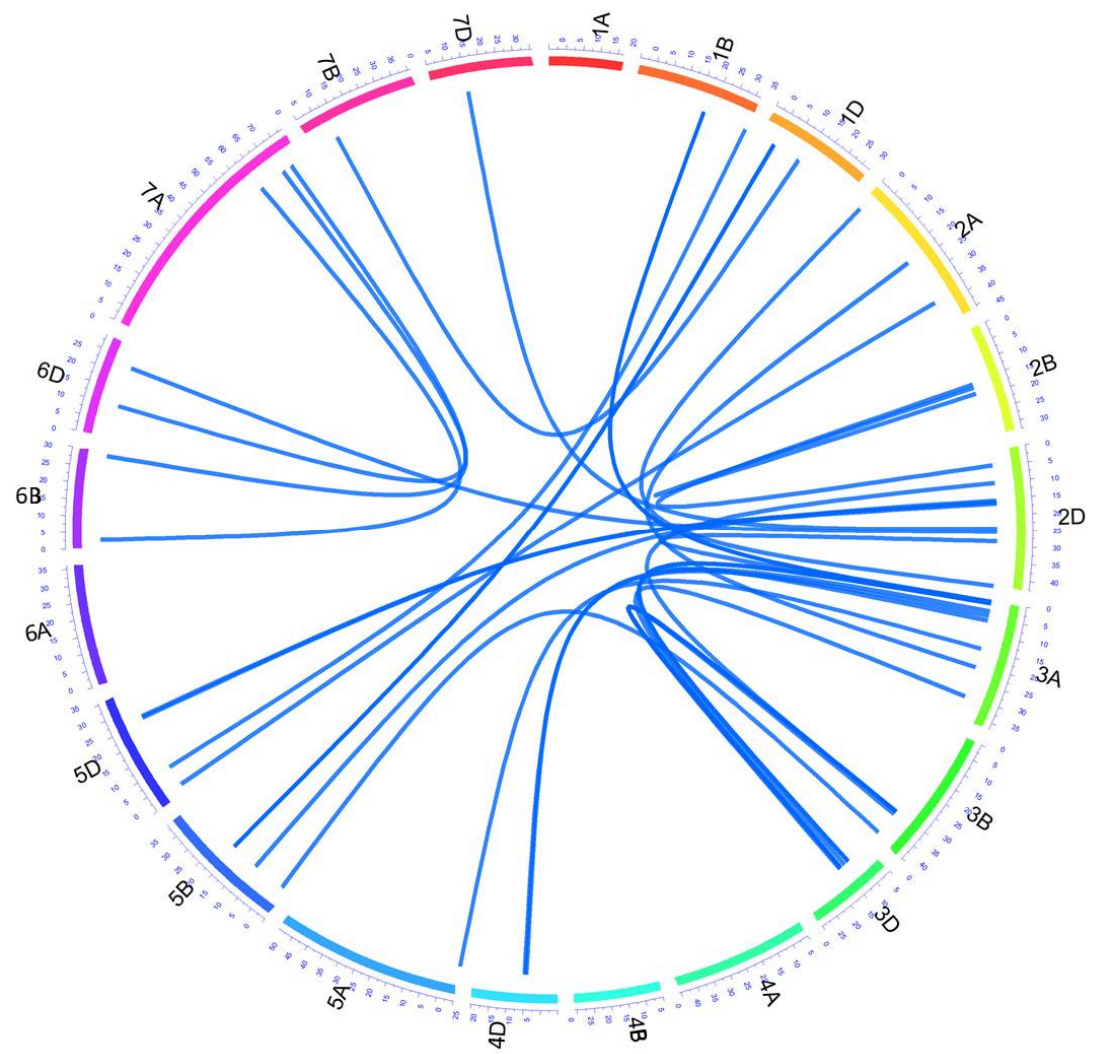
Figure 5. Epistasis QTL network in the ITMI/MP. Outer circular plot represents the hexaploid genome arranged in chromosomes (chrs) 1–21 (1A–7D) in clockwise direction. Numbers on colored outer circle represents cM on respective chrs. Blue-colored connections represent epistasis QTLs controlling different traits. For details, see Table S2.